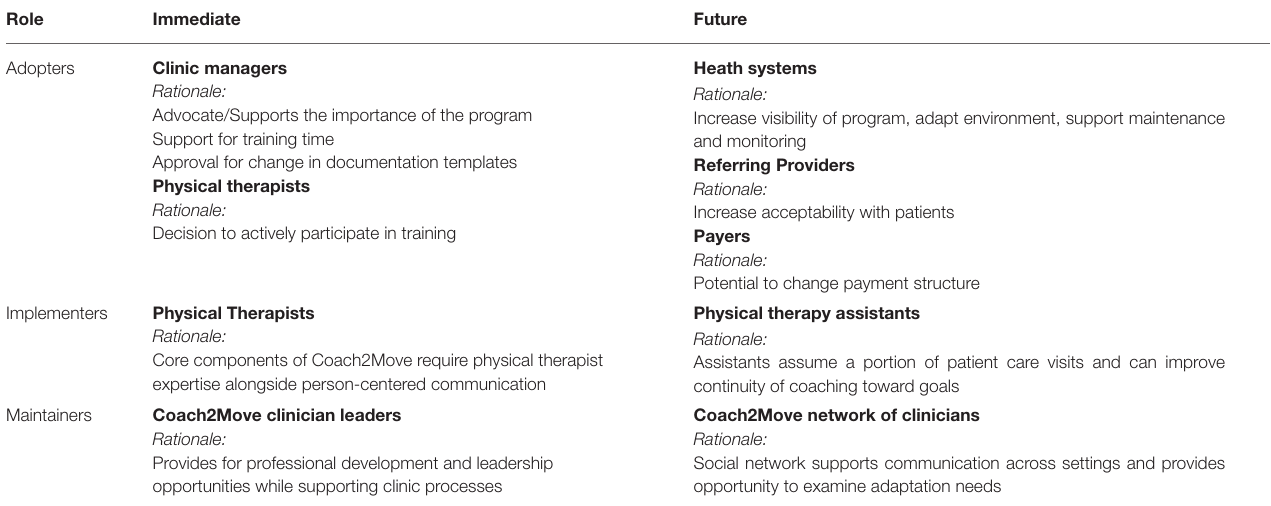
TABLE 2 | Implementation needs assessment, adopter, implementer, and maintainers.